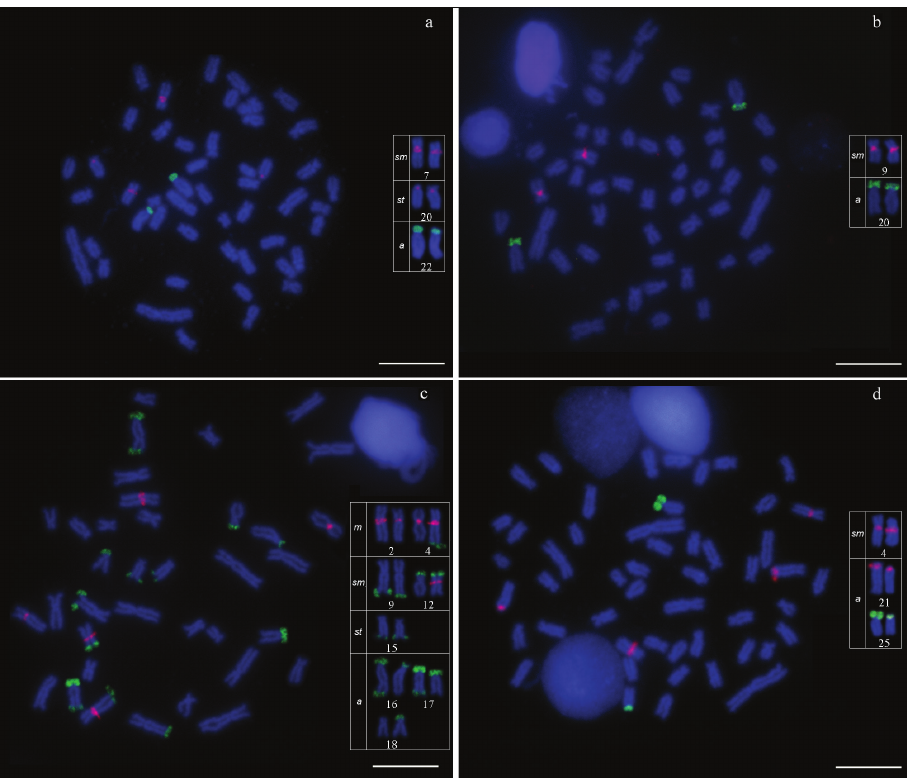
Figure 2. Metaphases chromosomes spreads after FISH with 5S rDNA probe (red) and 18S rDNA probe (green) of: a A. abramis b A. asuncionensis c A. correntinus d Astyanax sp. The 5S rDNA and 18S rDNA bearing chromosomes are framed. Bar = 10